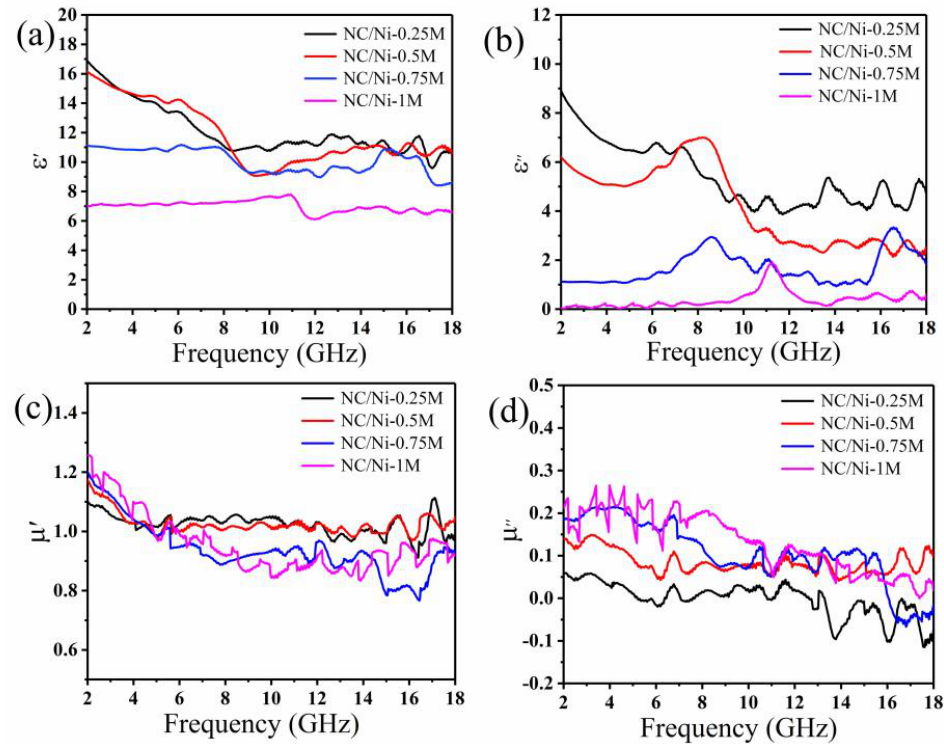
Figure 4. ( a ) Real and ( b ) imaginary parts of the complex permittivity, ( c ) real and ( d ) imaginary parts of the complex permeability of NC/Ni in paraffin wax with a mass loading of 50%.